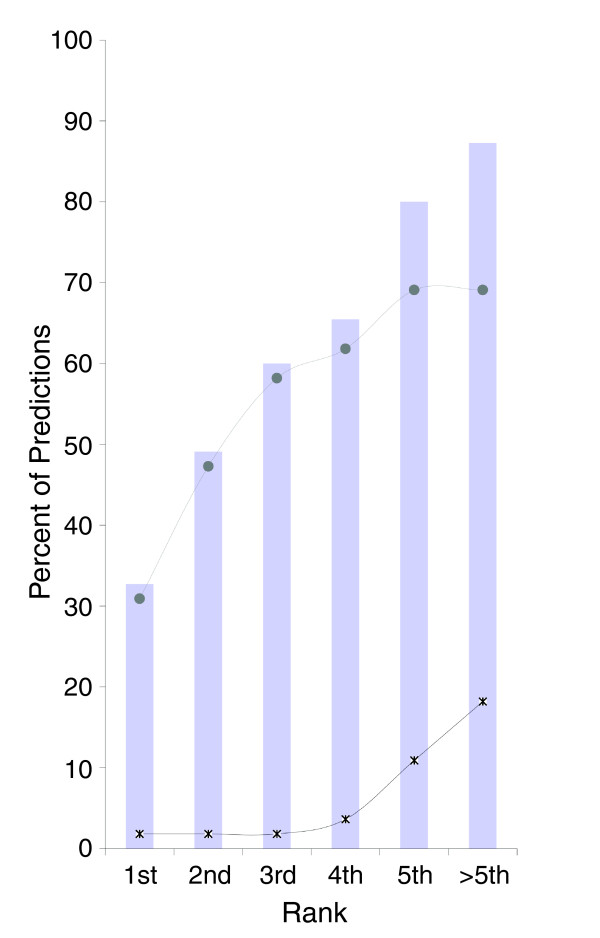
Specificity calculated by the COS(WR) method. The percent of accurate predictions derived from a screening of experimentally validated sequences with 30 different SFBS queries. The x-axis shows the rank of the true positive hits (that is, experimentally validated SFBSs) among the list of predictions derived from the screening. The top curve displays the percent of predictions higher than the COS(WR) threshold and the bottom curve shows the percent of predictions below the threshold.